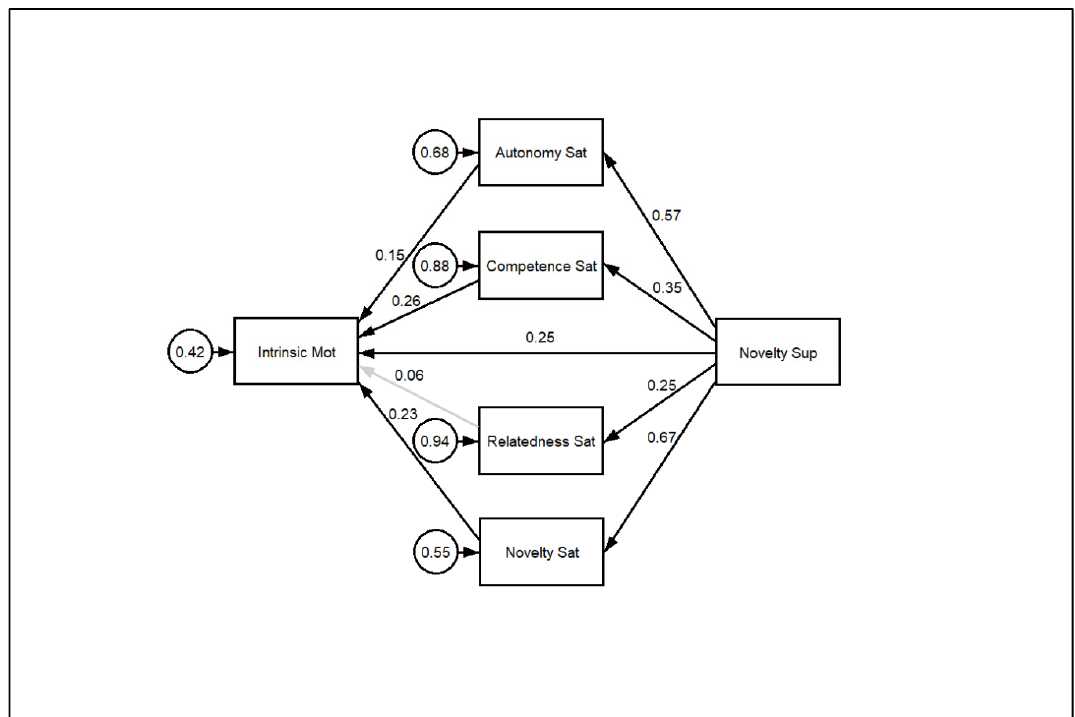
Figure 1. Multiple mediation model. Path analysis with standardized estimates. All estimates were significant ( p < 0.01), except for the path from relatedness satisfaction to intrinsic motivation.